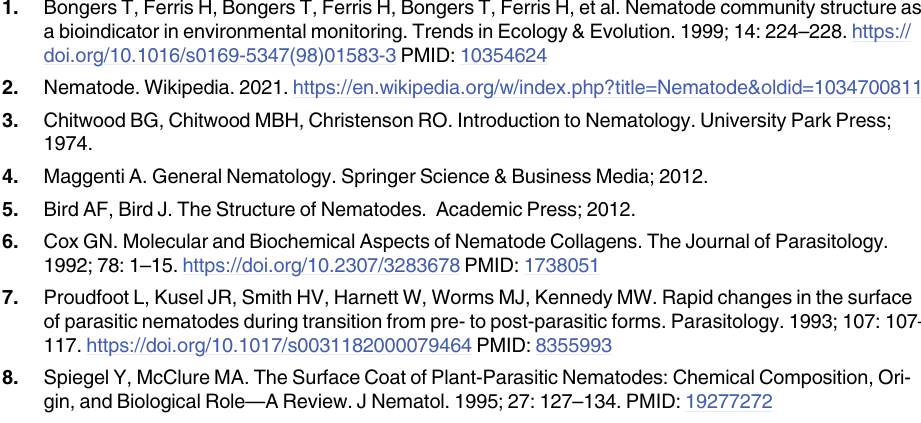
S2 Table. Epicuticlin sequences detected in different nematode